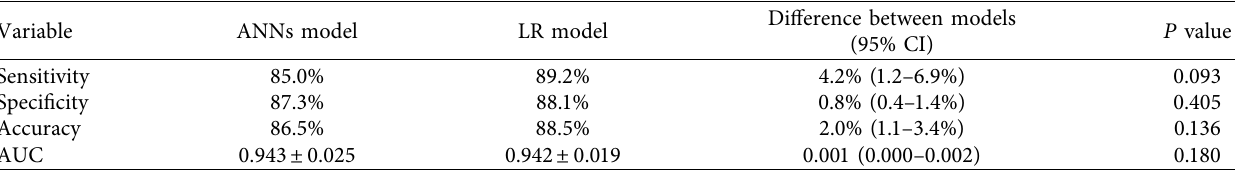
Table 4: Comparison of the ANNs model and LR model in predicting ARDS secondary to CAP in the test